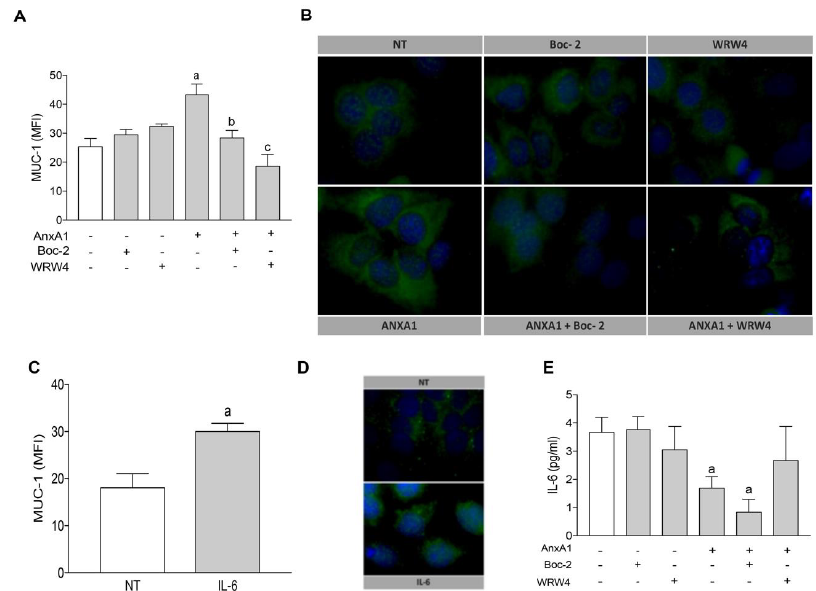
Figure 1. AnxA1 increased BeWo spheroid attachment via FPR1 on uterine epithelial cells. Uterine epithelial cells were treated with FPRs antagonists during 1 h and AnxA1 was added with spheroids. Uterine epithelial and spheroids were co-cultured during 2 h, and the percentage of adhered spheroids were calculated and considered as attached. ( − ) means absence and (+) means presence of treatments ( A ). Representative image of non-treated (NT) and AnxA1-treated uterine epithelial cells containing or not a spheroid is shown in ( B ). The data are expressed as mean ± standard error of 10 experiments. a p < 0.05 vs. NT; b p < 0.05 vs. AnxA1.